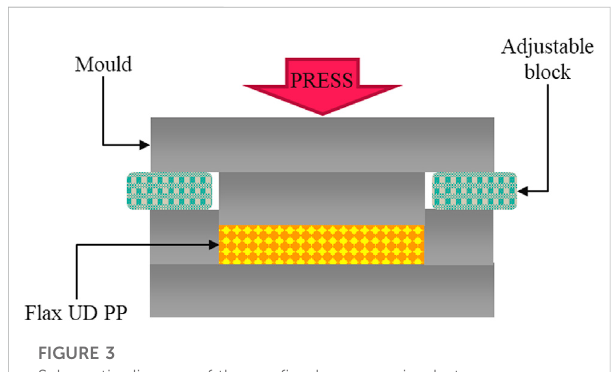
FIGURE 3 Schematic diagram of the con fi ned compression hot-press